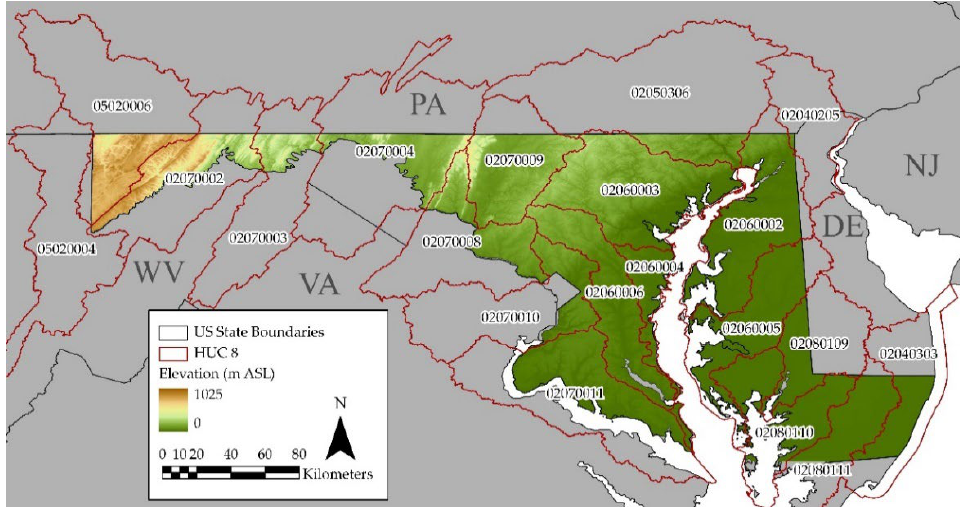
Figure 1. Surface topography of Maryland with United States Geological Survey Hydrologic Unit Code (HUC)-8 watersheds of Maryland overlaid.